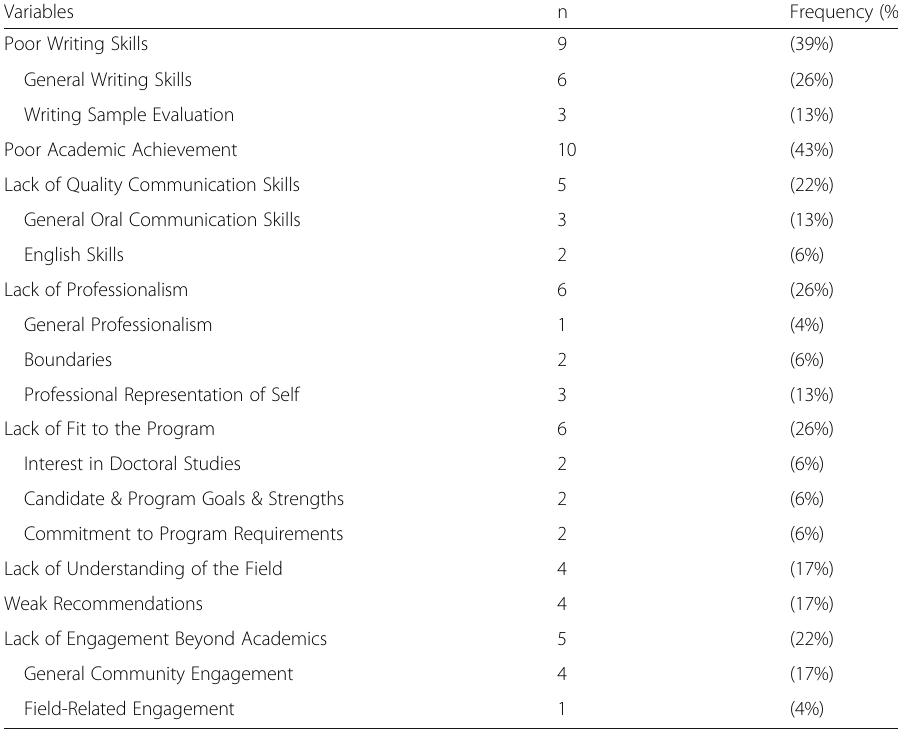
Table 4 Criteria indicating applicant is not a “ good fit ” through qualitative analysis